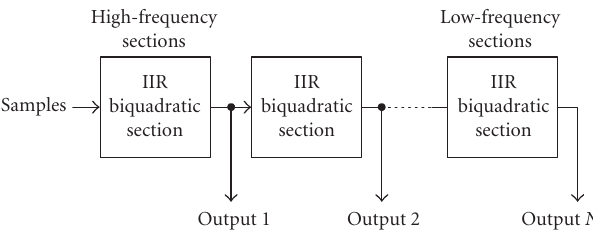
Figure 1: Cascaded IIR biquadratic section used in the Lyon and Mead cochlea